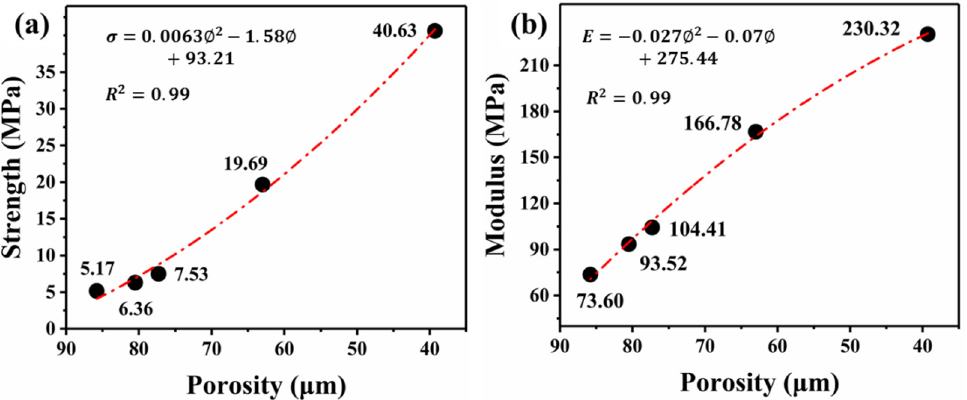
Figure 7. Compressive strength ( a ) and modulus ( b ) of the foam as a function of its porosity (cell size of nearly 20 μ m).